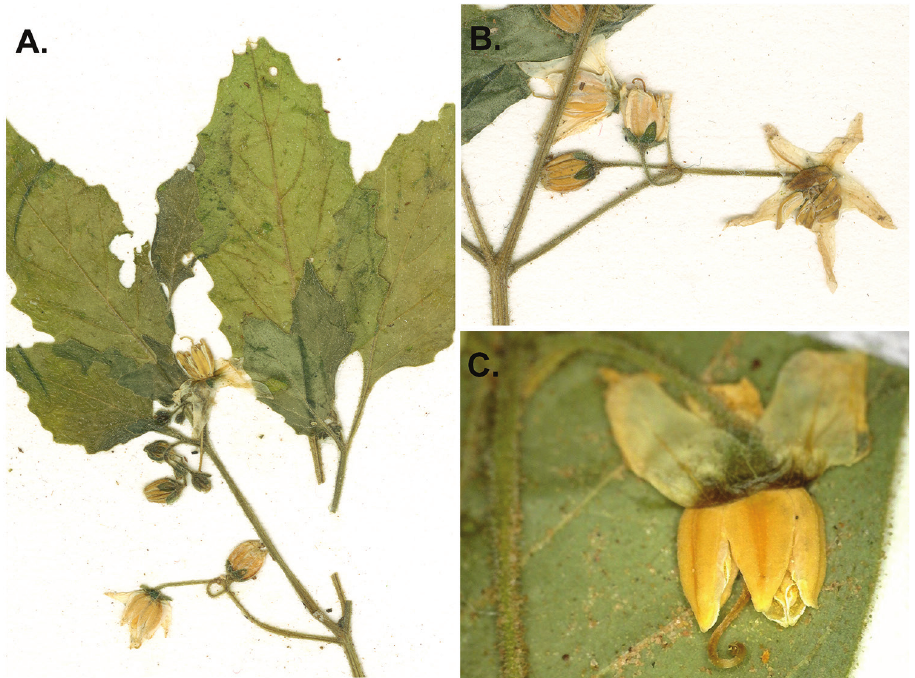
Figure 3. Solanum woodii . A Flowering stem B Inflorescence with details of buds, calyx and corolla C Flower at full anthesis ( A–B Wood 21787 ; C Nee et al. 51967 ; photos by Gwen